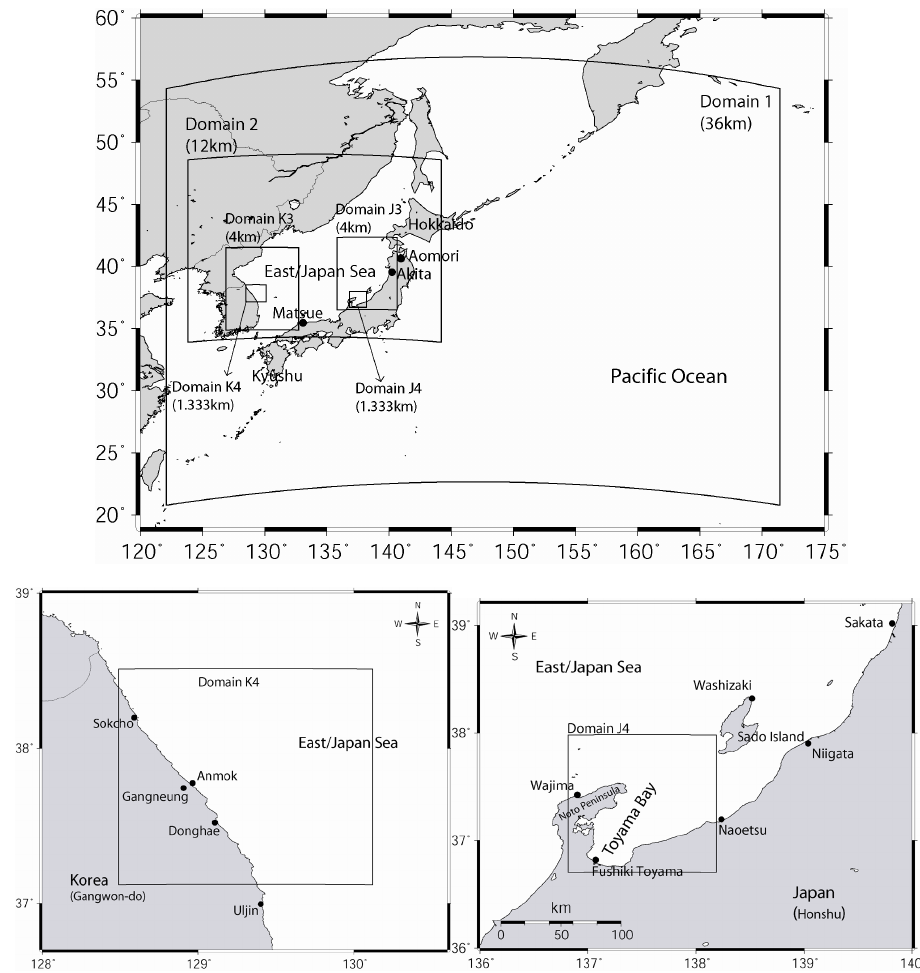
Fig. 7. Computational domains of meteorological and wave models for the events of February 1991 and February 2008 and locations of wave and weather observation stations along the coasts of Korea and Japan. In the event of February 1991, only the domains 1, 2, J3 and J4 were used while all domains including K3 and K4 were used for the event of February 2008.